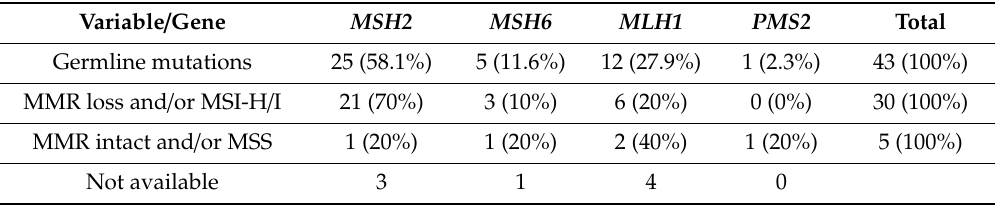
Table 3. Compiled results of genetic testing, MMR immunohistochemistry, and MSI analysis of sarcoma cases in LS patients from the literature